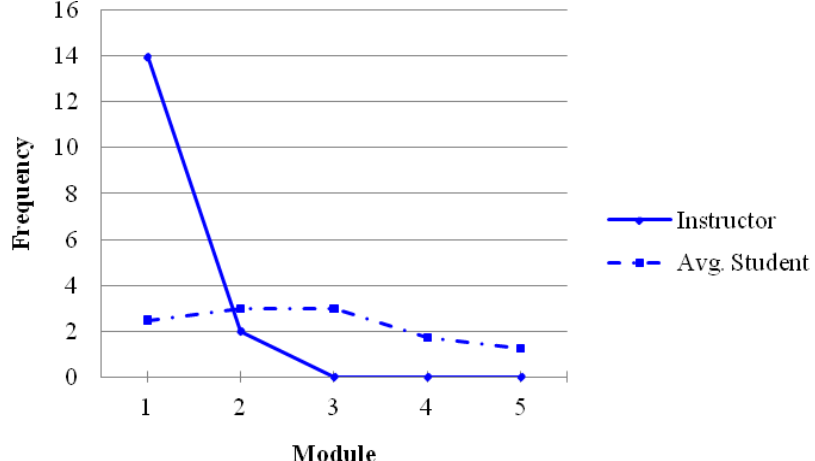
Figure 3 . Course B: Instructor TP versus average student